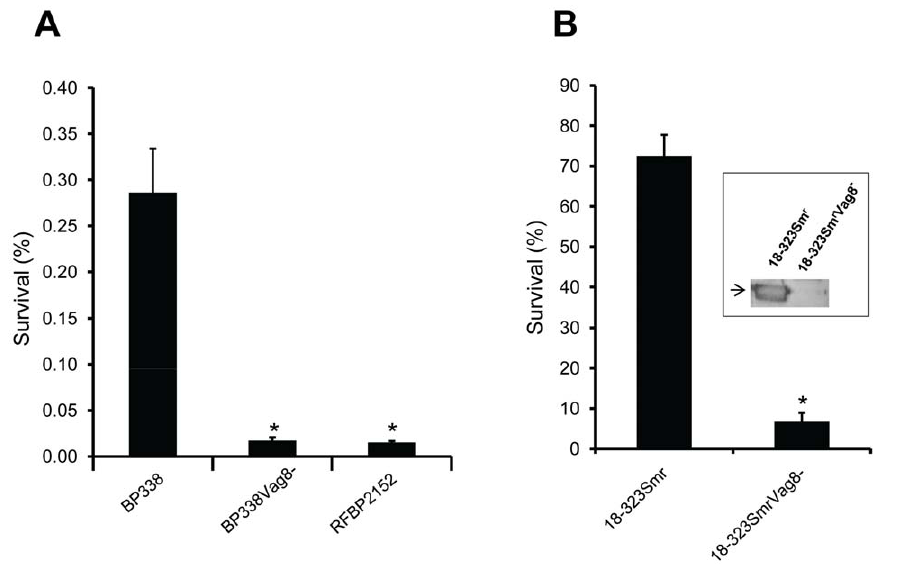
Figure 5. Results of serum killing assays. A B. pertussis BP338 and its isogenic mutants, RFBP2152 ( brkA :: gent ) and BP338Vag 2 ( vag8 ::pEG7- Vag8). Shown are means of percent survival 6 SEM of a representative experiment done in triplicate, *, P , 0.04 vs. wild type strain. The comparison of BP338 and BP338Vag8 2 was done 4 times independently, in triplicate; three of those experiments included RFBP2152. B B. pertussis 18–323Sm r and its isogenic mutant 18–323Sm r Vag8 2 ( vag8 ::pEG7-Vag8). Shown are means of percent survival 6 SEM of a representative experiment done twice in triplicate. *, P , 0.004. Inset shows binding of C1inh (arrow) to wild type 18–323Sm r but not to 18–323Sm r Vag8 2 .